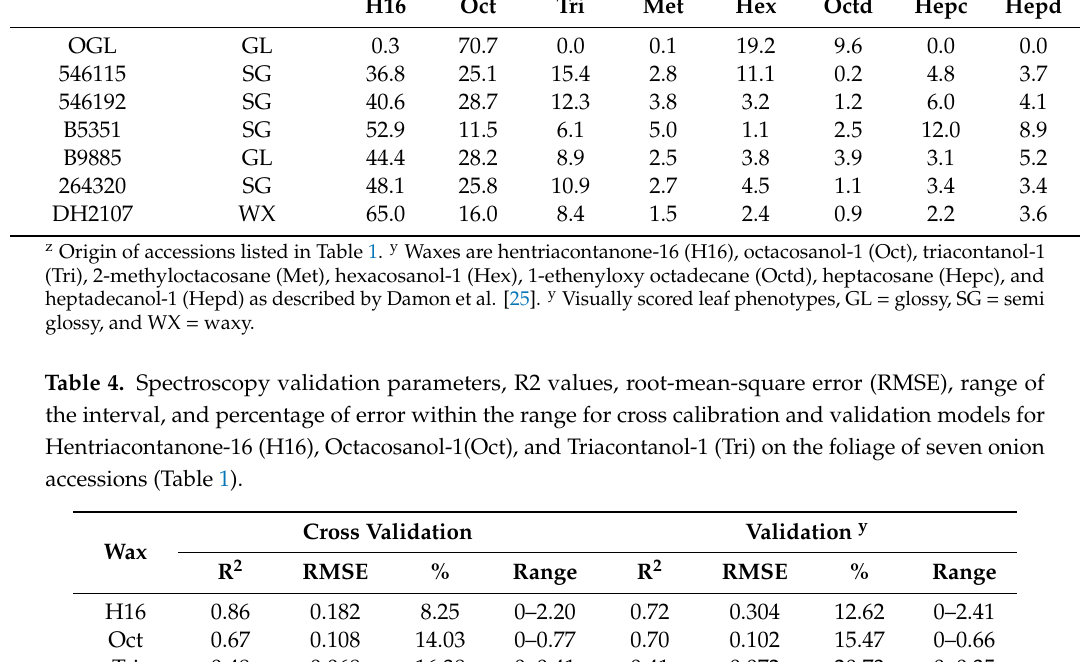
Table 3. Percentages of individual waxes on leaves of plants from seven onion accessions measured with GCMS (Table 1). Accessions are ranked from the lowest to highest percentages of H16.